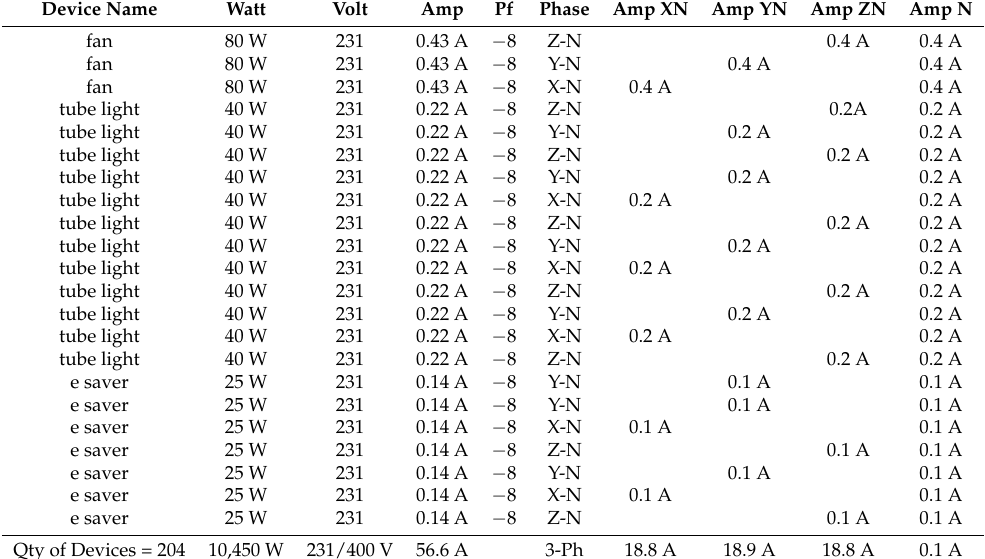
Table 10. Allama-Iqbal-Hostel proposed load